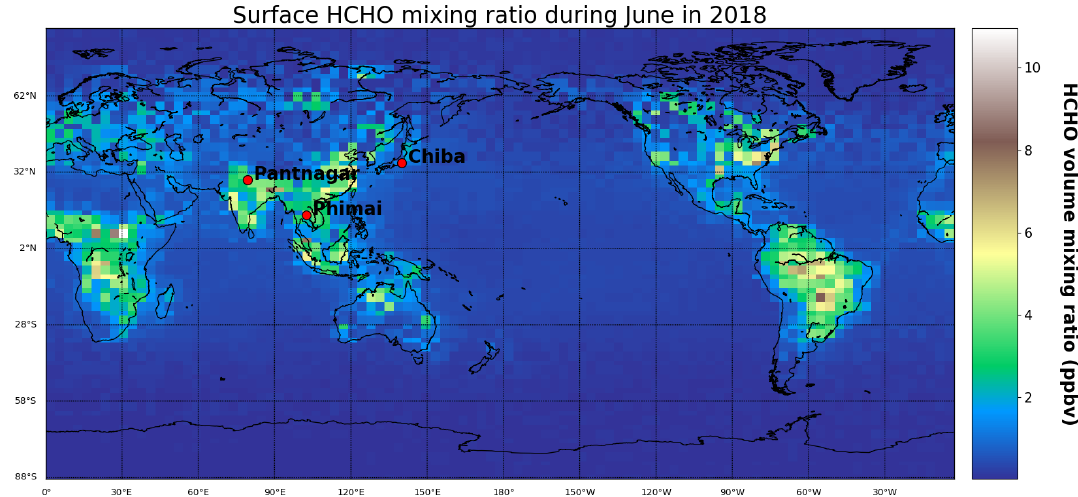
Figure 1. Surface HCHO mixing ratio in June 2018, simulated using the CHASER model. The red points represent the locations of the observation sites, which are part of the A-SKY